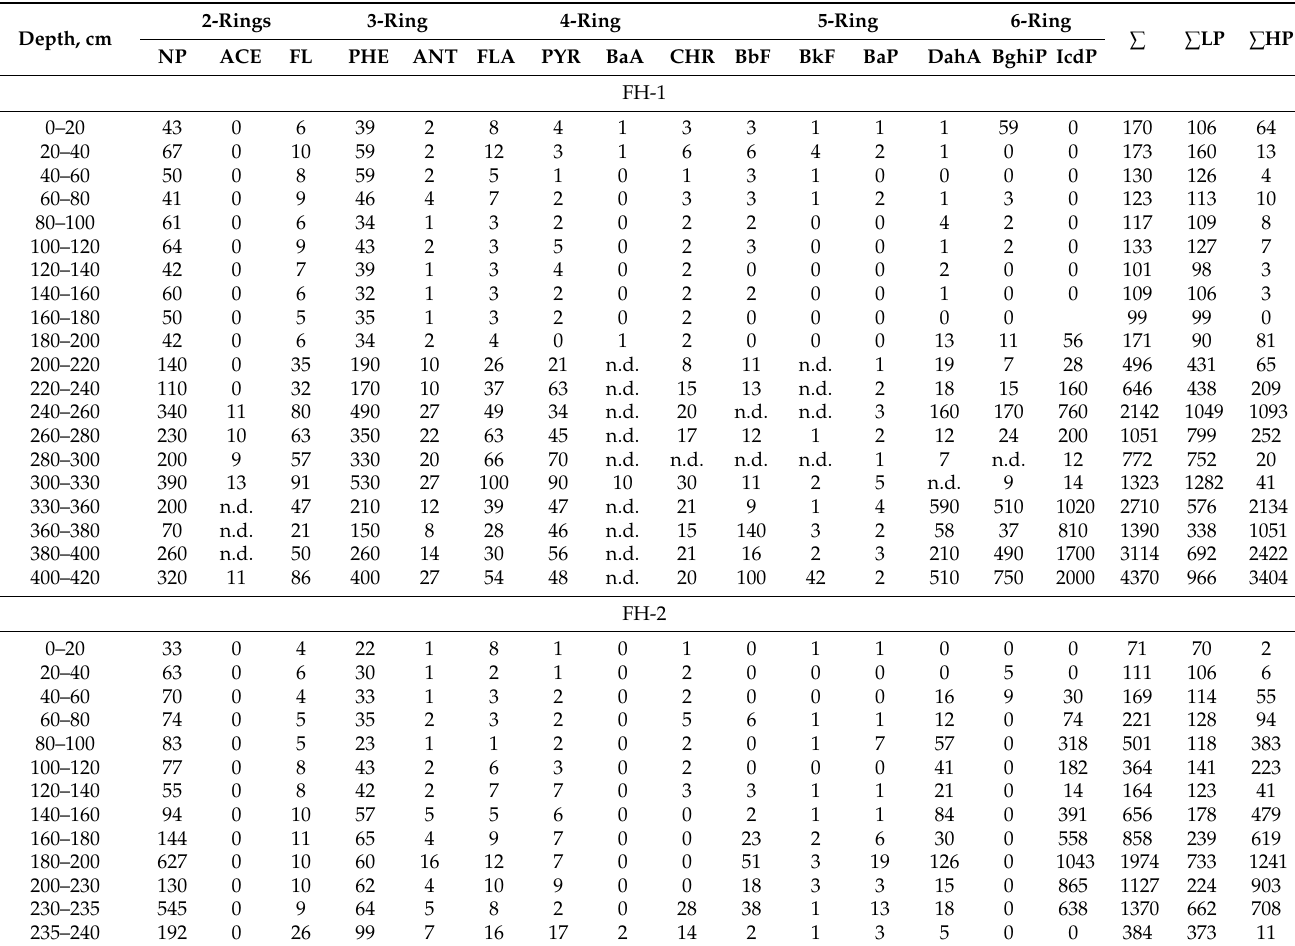
Table A1. Content of PAHs in soils, ng g − 1